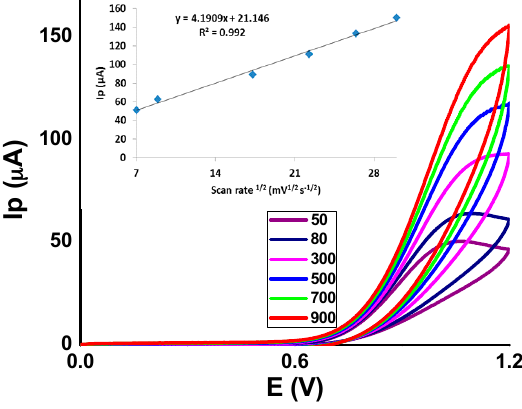
Figure 5. CVs showing the effect of scan rates on peak current values of 1 mM nitrite solution in phosphate buffer at pH 7.0 using Px-CuO NSs-modified GCE: the inset depicts the dependence of peak current values on the square root values of the scan rates.